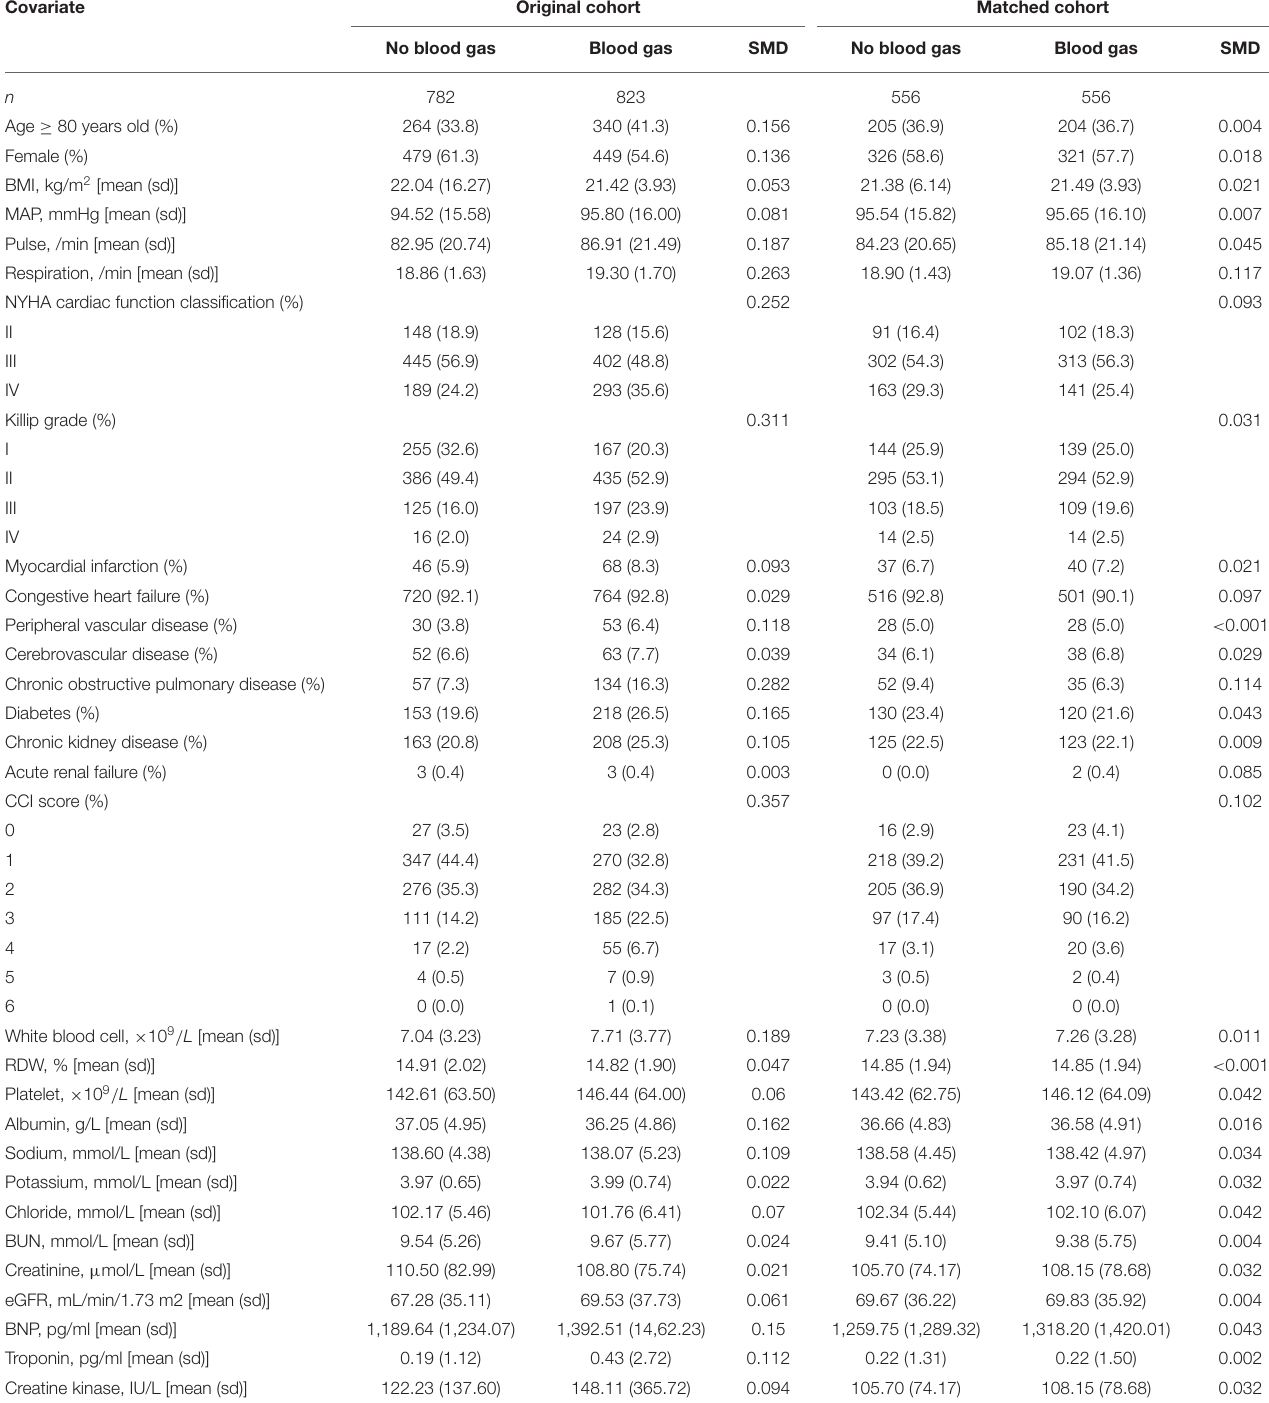
TABLE 1 | Baseline characteristics of